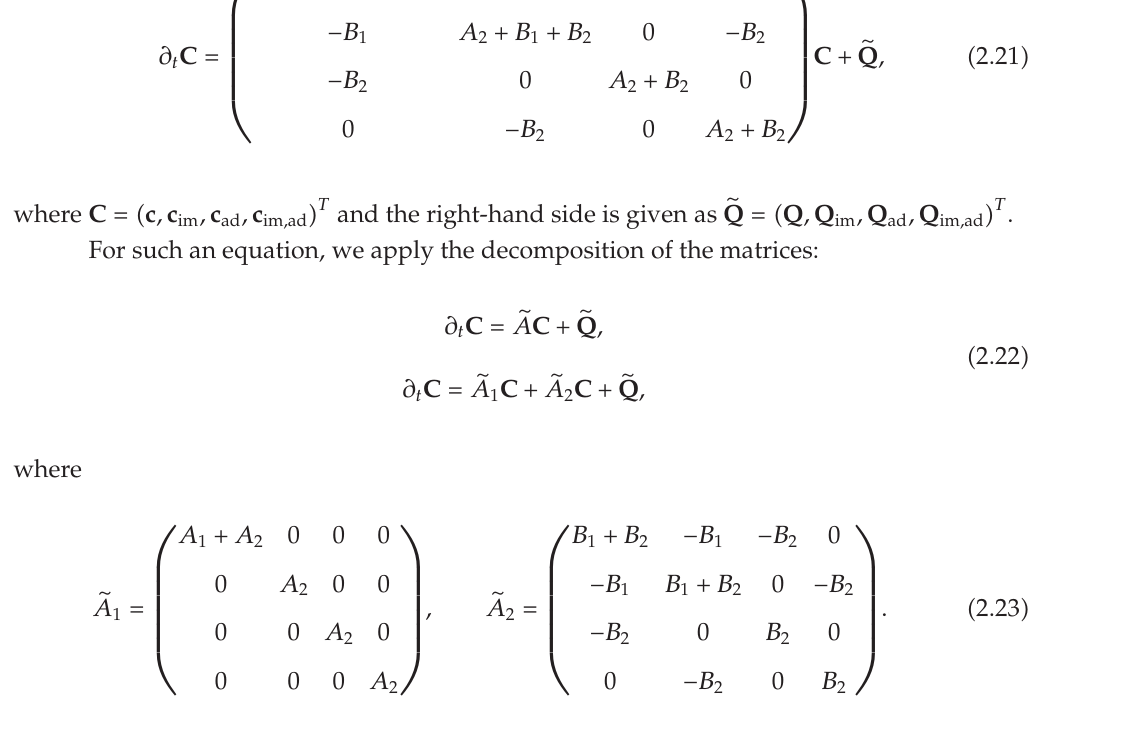
Algorithm 2.4. We divide our time interval (cid:2) 0 , T (cid:3) into subintervals (cid:2) t n , t n (cid:8) 1 (cid:3) , where n (cid:9) 0 , 1 , . . .N , t 0 (cid:9) 0, and t N (cid:9) T . We start with n (cid:9)